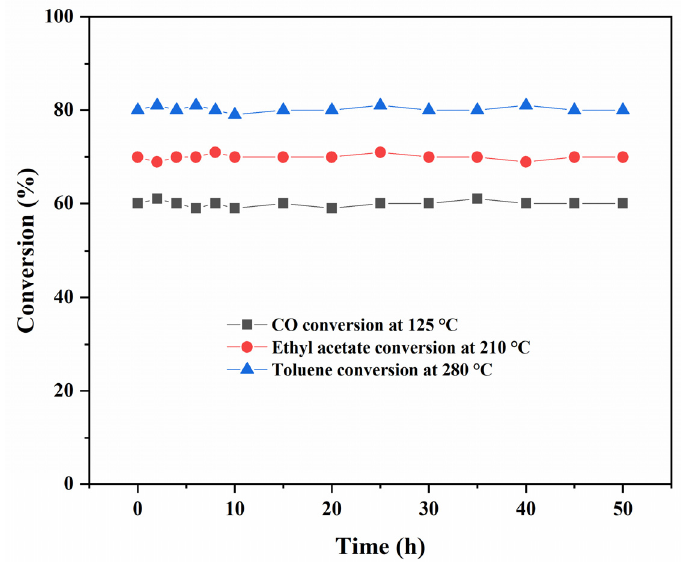
Figure 10. Catalytic stability of the 5Ni/OMS-2 sampleinCOoxidation at 125 °C and SV = 60,000 mL/(g·h), ethyl acetate oxidation at 210 °C and SV = 240,000 mL/(g·h), and toluene oxidation at 280 °C and SV = 240,000 mL/(g·h). Table 4. A comparison on specific reaction rates for CO at 145 °C, ethyl acetate at 220 °C, and toluene at 275 °C over the catalysts reported in the present work and the literature.